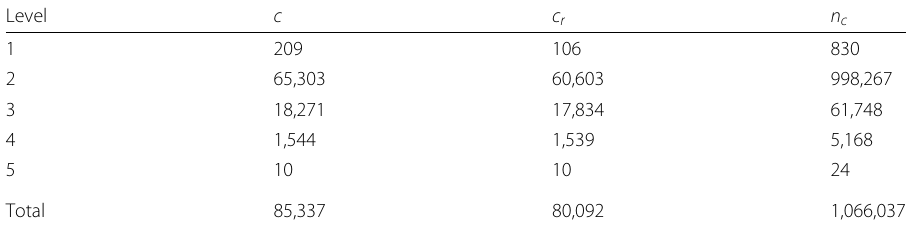
Table 1 The numbers of communities identified at different levels of the Japanese production network using the Infomap